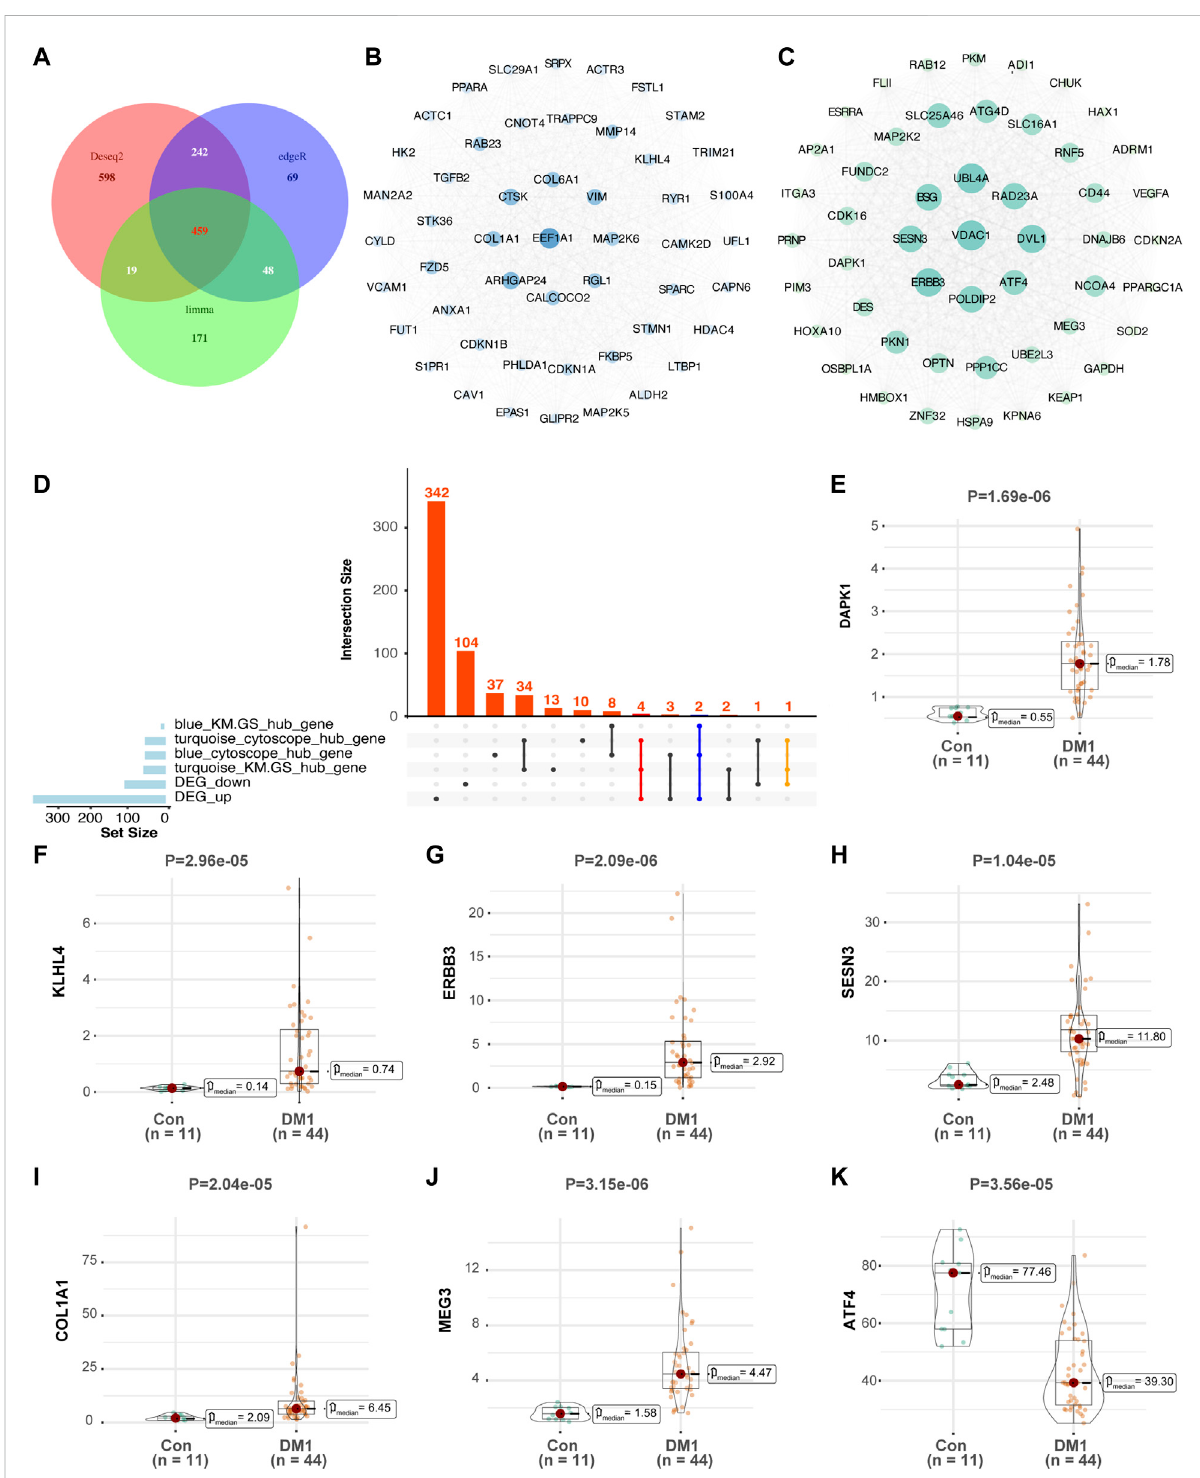
FIGURE 3 Expression of autophagy-associated hallmark genes in GSE86356 dataset. (A) Intersection of three parametric ways (DESeq2, edgeR and limma-voom) of differential expression genes by Venn diagram. According to the degree method, top 50 hub genes were selected by CytoHubba betweenblue (B) andturquoisemodules (C) ,Genetermsarerepresentedasnodes,andthenodesizeindicatesweighteddegreescore. (D) Theupset plot summarizes overlap of genes between each gene set. (E – K) Expression levels of DAPK1, KLHL4, ERBB3, SESN3, COL1A1, MEG3, and ATF4 were signi fi cantly increased in DM1 patients, whereas the expression of ATF4 was signi fi cantly decreased in DM1 patients. Con, control; DM1, myotonic dystrophy type